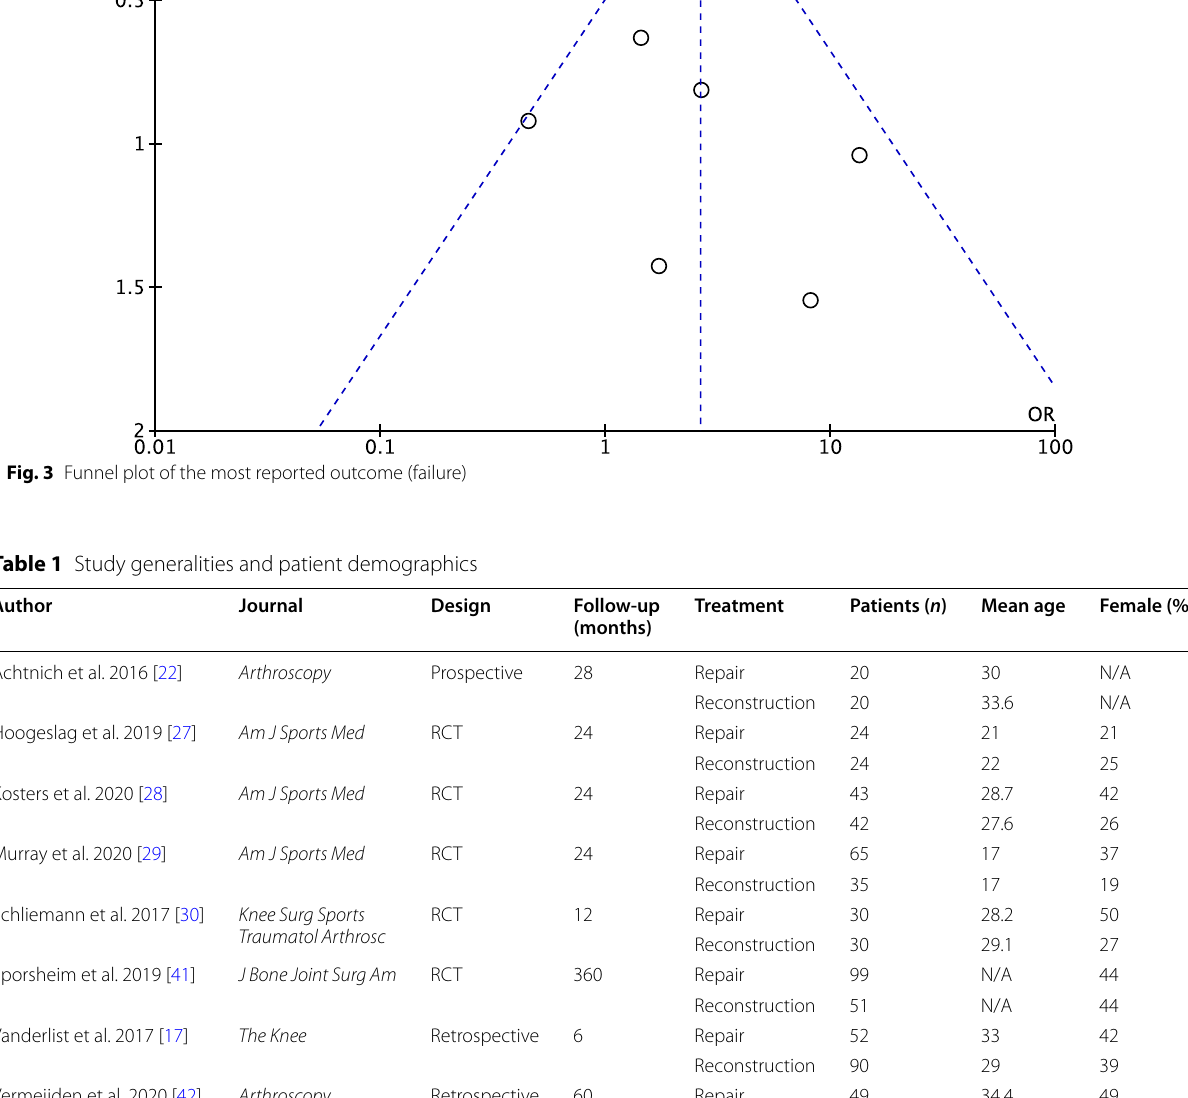
RCT: randomized control